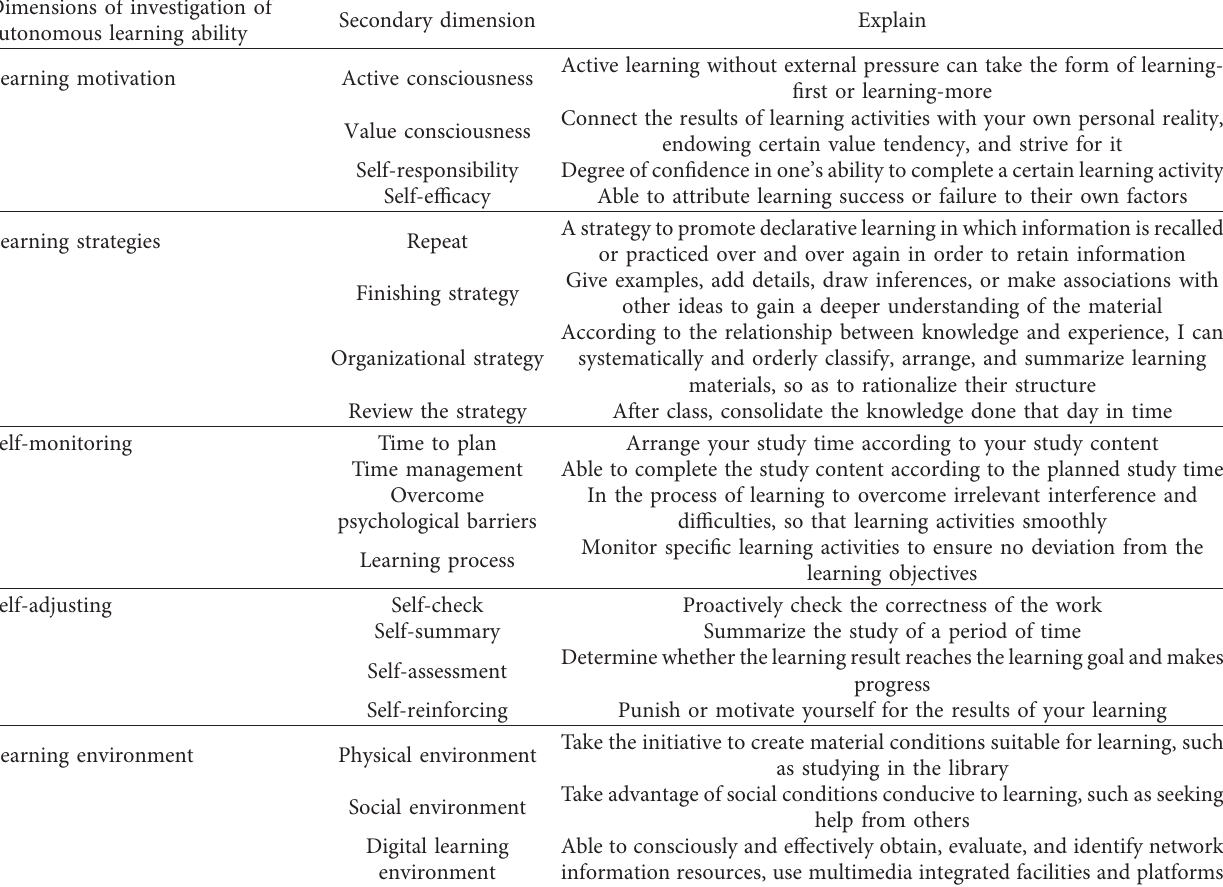
Table 1: Dimensions of investigation on autonomous learning